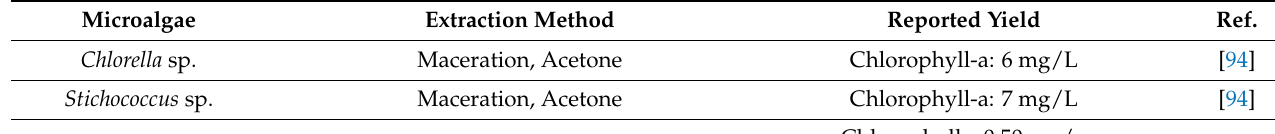
Table 10. Summary of different studies on the extraction of bioactive pigments from microalgae. Microalgae Extraction Method Reported Yield